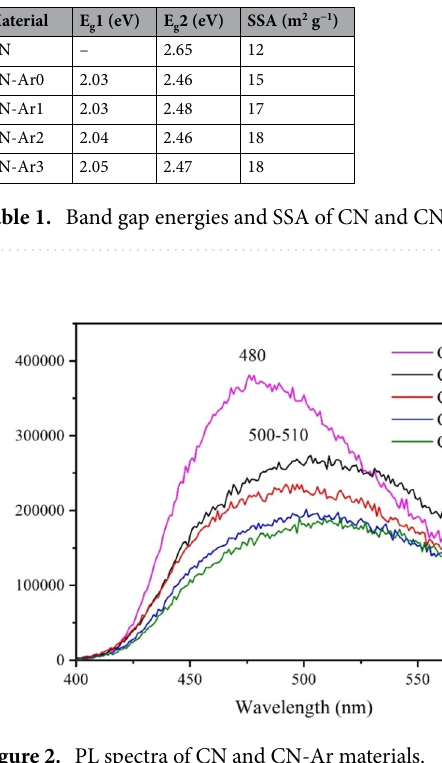
Figure 2. PL spectra of CN and CN-Ar